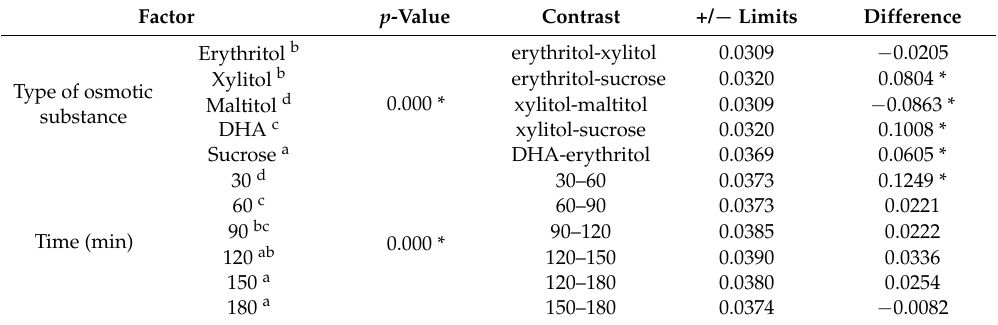
Table 10. The influence of osmotic agents and pre-treatment time on CR during